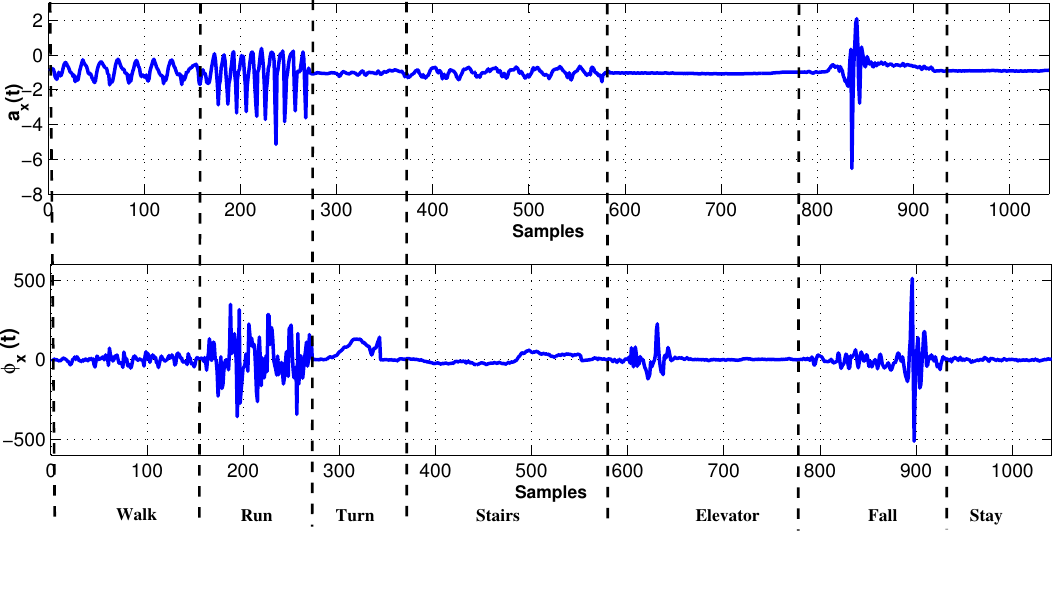
Figure 6. Tilt angle signals for turning